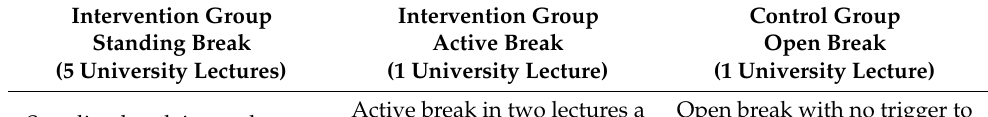
Figure 1. Presentation slide shown to the standing break intervention group as trigger to stand up. Table 2. Intervention and control